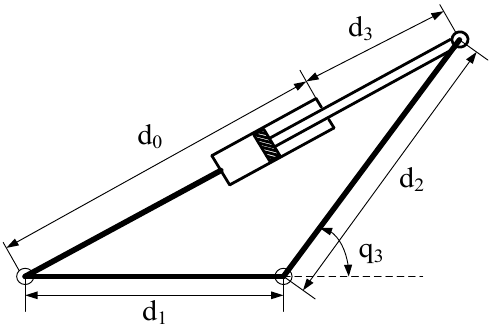
Figure 2. The architecture of the last link.